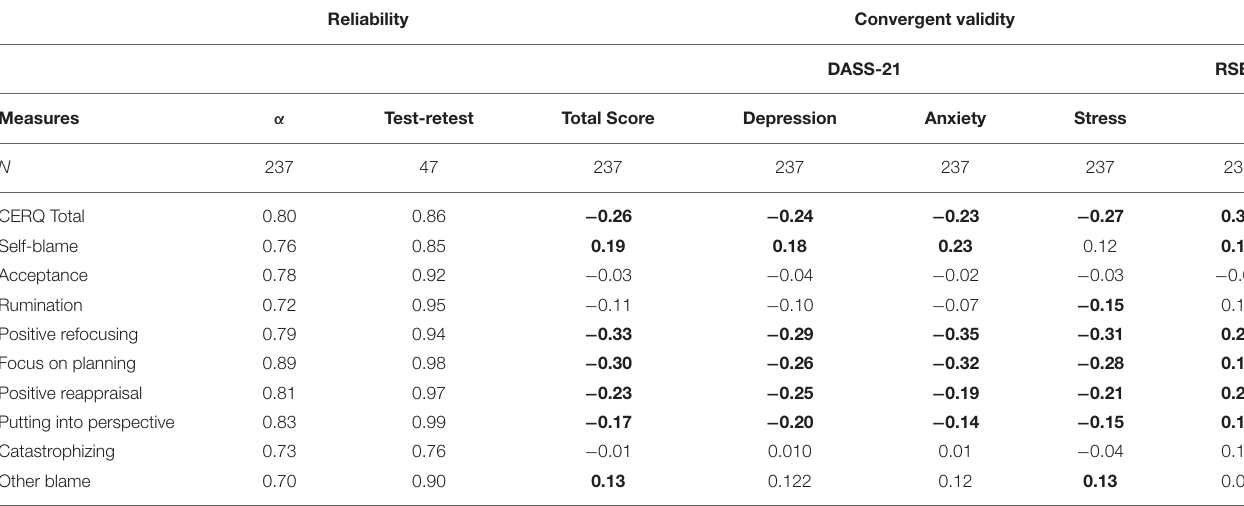
TABLE 2 | Internal consistency reliabilities (Cronbach’s α ) and 10–14 day test–retest reliabilities (Pearson Product-Moment Correlations) of the CERQ total and subscale scores, and Pearson Product-Moment Correlations of the CERQ scores with the DASS-21 total and subscale scores and the Rosenberg Self-Esteem Scale ( N = 47 for test–retest reliability; N = 237